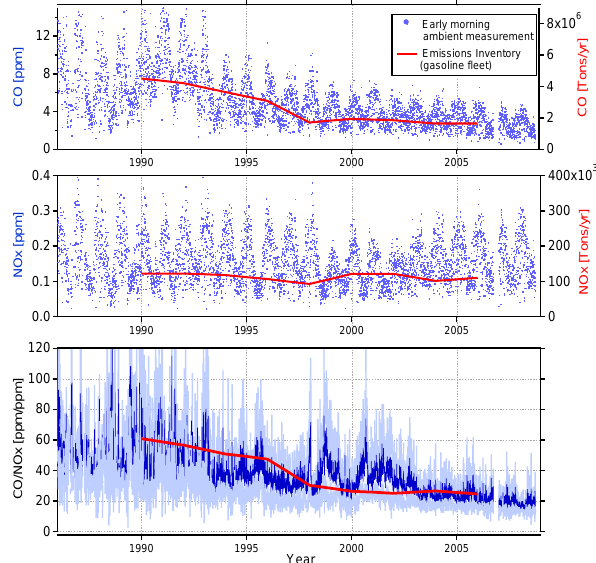
Fig. 4. Comparison of early morning ambient average CO, NO x and CO/NO x trends with official emissions estimates from the gasoline vehicle fleet in Mexico City (SMA, 2008a). Dark-blue and light- blue colored lines in the CO/NO x levels represent the average and the 1-sigma standard deviation of daily measurements from all mon- itoring stations,